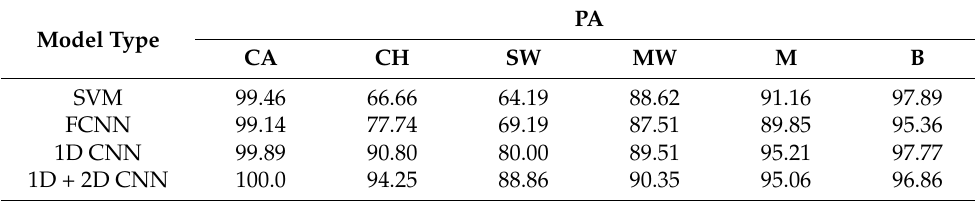
Table 5. Producer’s accuracy of the DNN models and